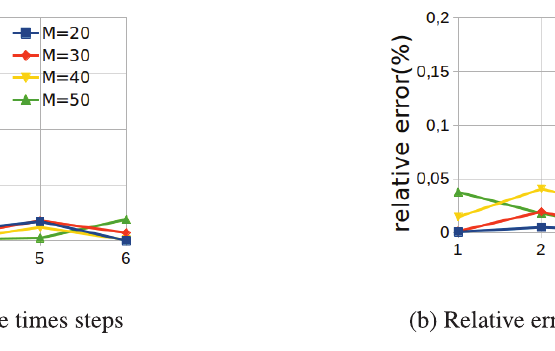
Fig. 3. Relative errors on ρc without noise on temperature fields for PA material for several times steps